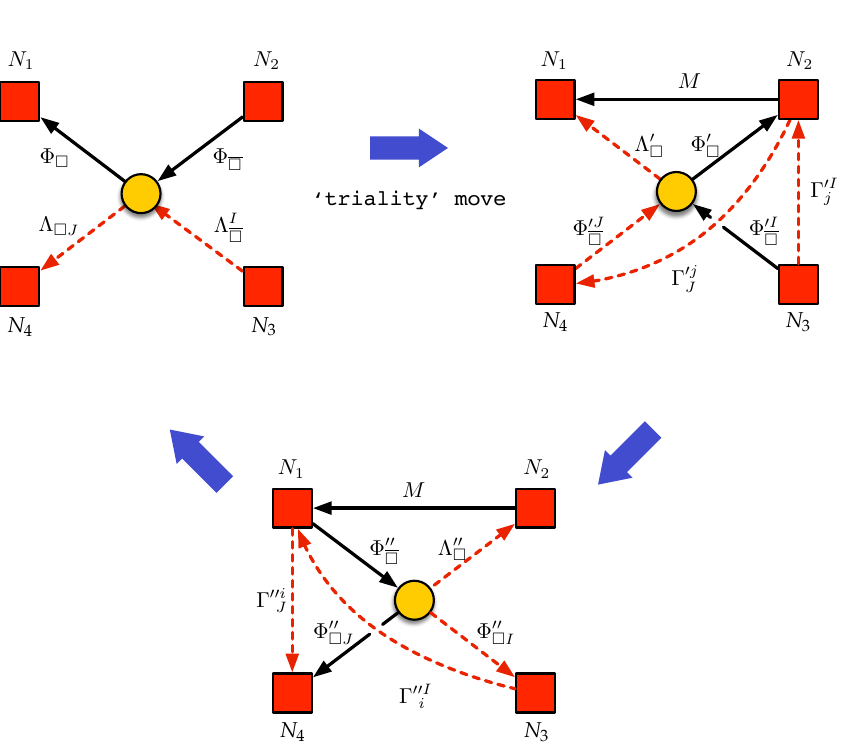
Figure 6 . The triality (order-3) cycle of 0 d acting on the 0 d theory, one can recover the full quadrality cycle of (cid:12)gure